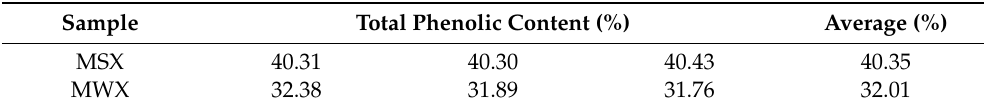
Table 1. Total phenolic content of maple food extracts, including MSX and MWX, measured by the Folin–Ciocalteau method.